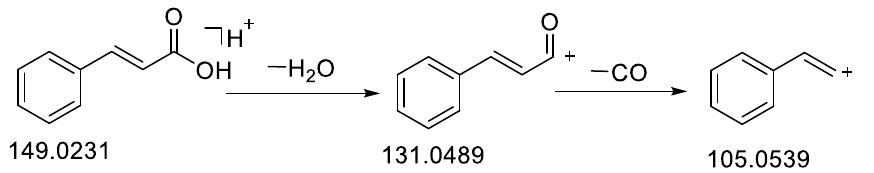
Figure 1. Fragmentation pathway of trans -cinnamic acid in positive ion mode.